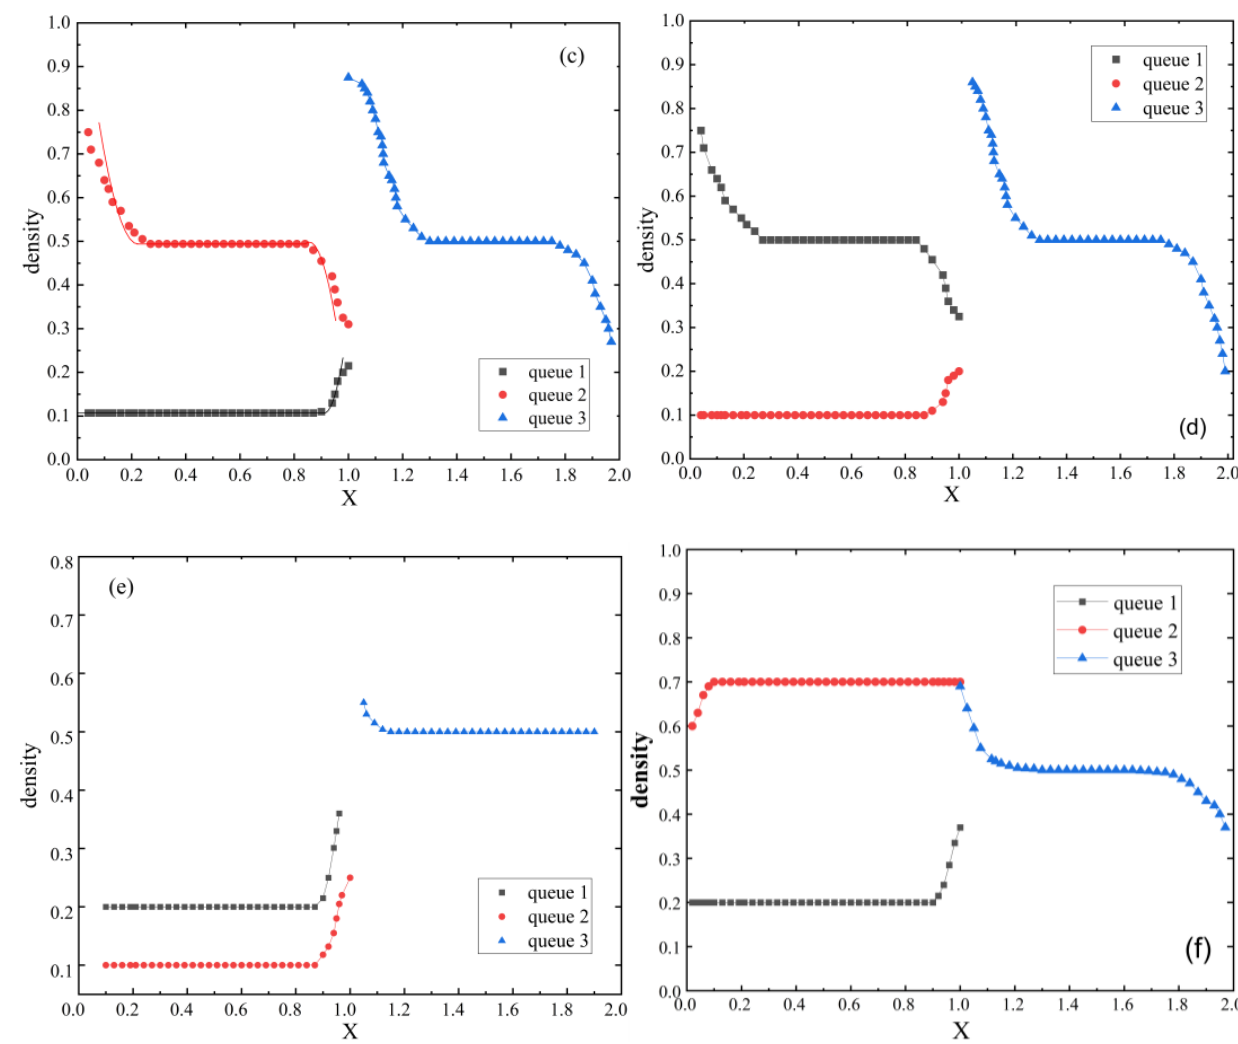
Figure 12. ( a ) ( LD , LD , MC ) , α 1 = 0.2, α 2 = 0.1, β = 0.8; ( b ) ( LD , HD , MC ) , α 1 = 0.5, α 2 = 0.1, β = 0.8; Figure 12. (𝐚) (𝐿𝐷, 𝐿𝐷, 𝑀𝐶), 𝛼 ( c ) ( LD , MC , MC ) , α 0.8 ; (𝐜) (𝐿𝐷, 𝑀𝐶, 𝑀𝐶), 𝛼 α 1 = 0.2, α 2 = 0.1, β = 0.4; ( f ) ( HD , LD , MC ) , α 1 = 0.25, α 2 = 0.5, β = (𝐞) (𝐿𝐷, 𝐿𝐷, 𝐿𝐷), 𝛼